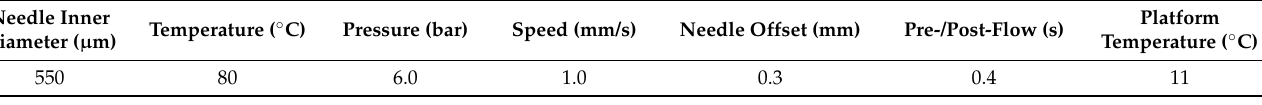
Table 1. General parameters for 3D